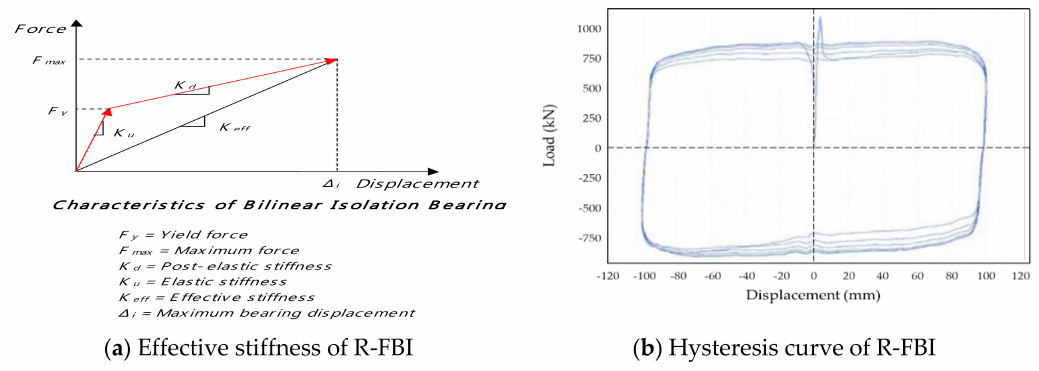
Figure 7. Effective stiffness and hysteresis curve of resilient friction base isolation system. ( a ) Characteristics of bilinear isoaltions bearing; ( b ) Quality test result of the R-FBI